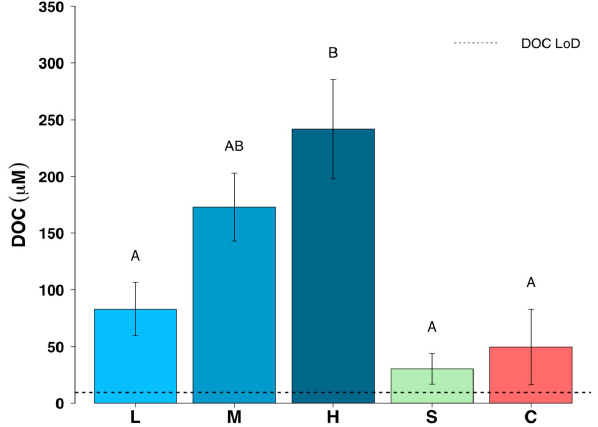
Figure 5. Dissolved organic carbon (DOC) concentrations for all five surface habitats (mean ± SE, n = 19 for L, M, H, n = 10 for S and n = 14 for C). L – ice with low visible impurities, M – ice with medium visible impurities, H – ice with high visible impuri- ties, S – supraglacial stream water and C – cryoconite hole water. The LoD line depicts the limit of detection of the instrument. Up- percase letters denote homogeneous subsets derived from post hoc Tukey HSD analysis on a significant one-way ANOVA in relation to habitat